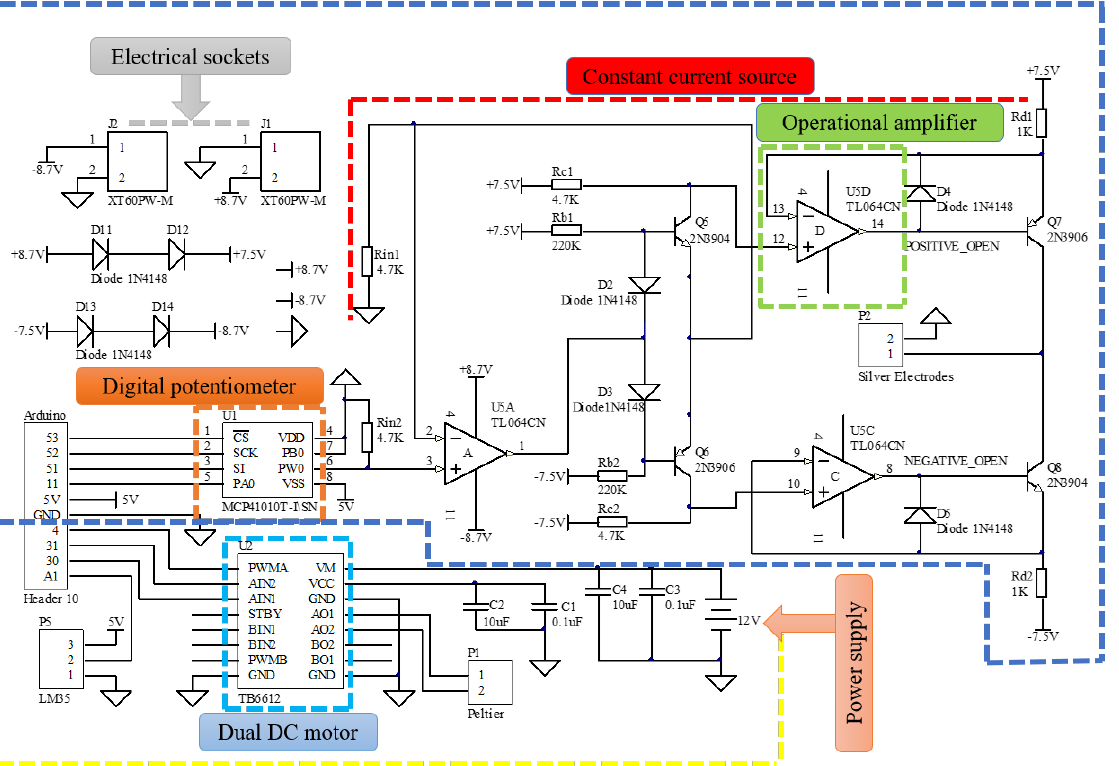
Figure 3. Schematic diagram of e-taste.